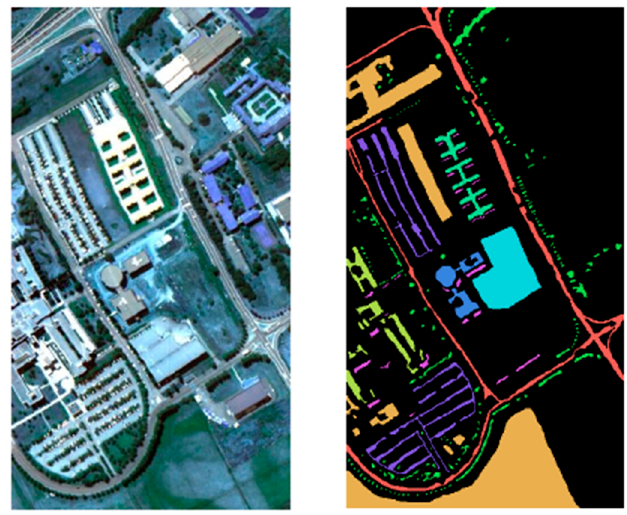
Figure 2. PaviaU dataset diagram. The left is a pseudo-color map, and the right is a true feature category map.